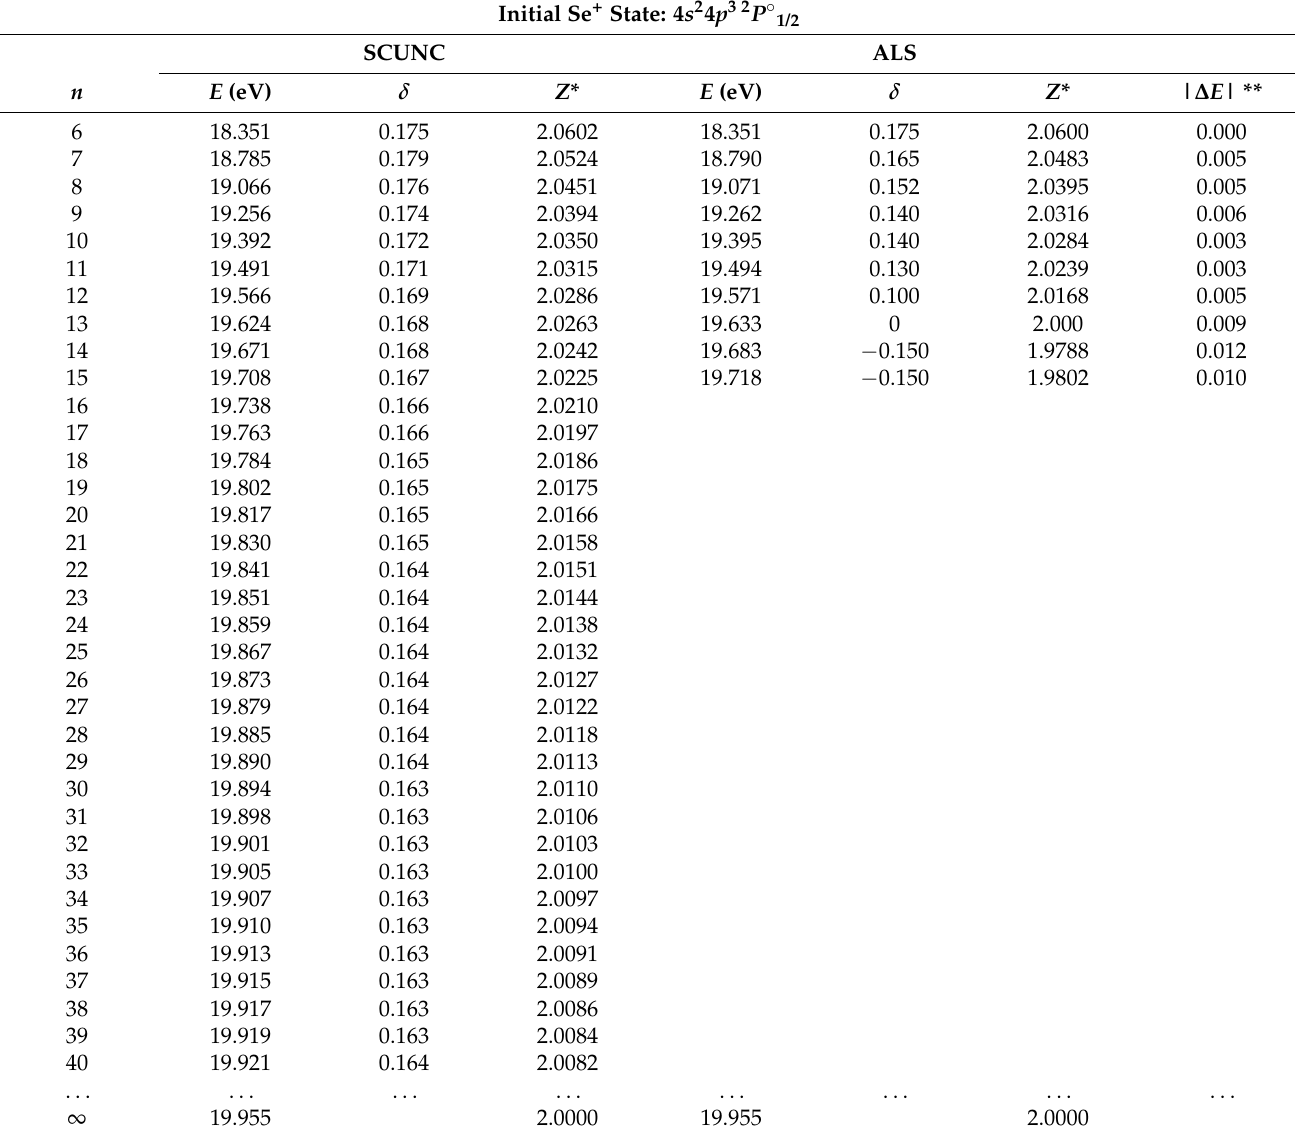
Table 5. Energy resonances ( E ), quantum defect ( δ ) and effective charge ( Z *) of the 4 s 2 4 p 2 ( 1 D 2 ) nd ( 2 P 1/2 ) Rydberg series originating from the 4 s 2 4 p 3 2 P ◦ 1/2 metastable state of Se + converging to the 1 D 2 series limit in Se 2+ . The present results (SCUNC) are compared with the experimental data from ALS measurements [6]. The uncertainties in the experimental energies are stated to